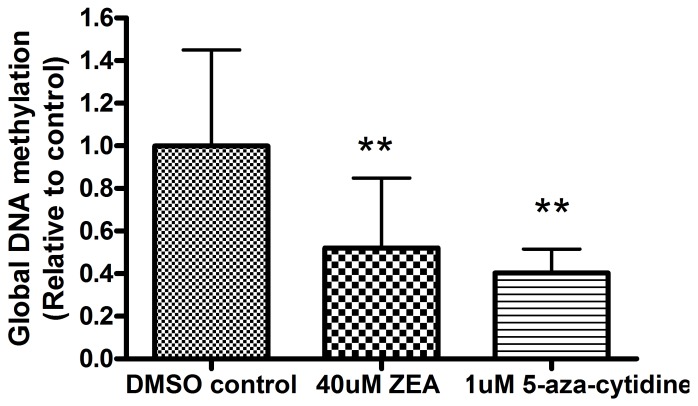
Induction of global DNA demethylation in BEAS-2B cells by exposure to ZEA for 24 h.Results represent the mean± SD of at least 3 independent experiments and ** represents p<0.01 significantly different from DMSO control values as assessed by t-test.